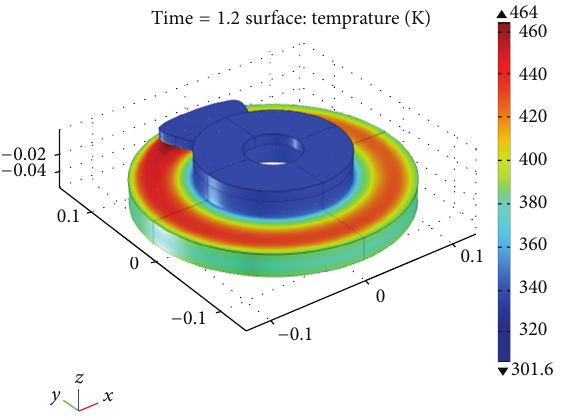
Figure 1: Temperature distribution for AMC disc and aramid pad at 𝑡 = 1.2 seconds.